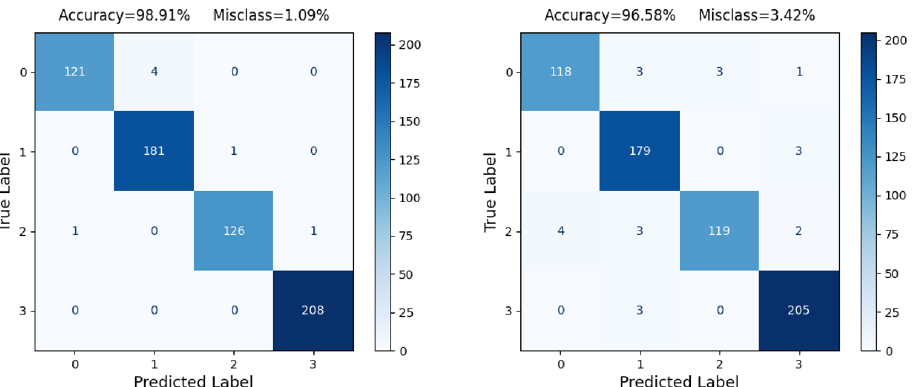
Figure 17. Confusion matrix for the Dop-NET using the training dataset and evaluated on the specific test set. Results for an LSM with 960 neurons, C inp = 5 and using SVM classifier. The left table shows the results for normalized S l and the right for variable S l